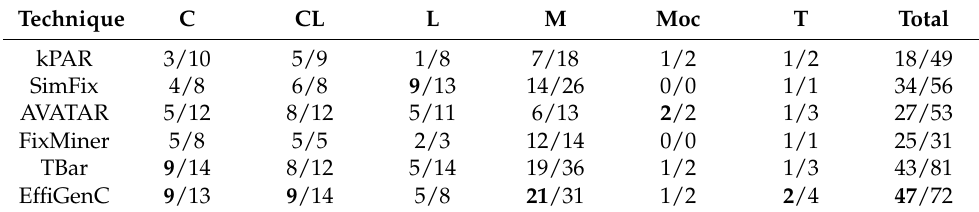
Table 6. Number of Defects4j bugs that are correctly/plausibly fixed by APR tools. “C, CL, L, M, Moc, T” represent Chart, Closure, Lang, Math, Mockito and